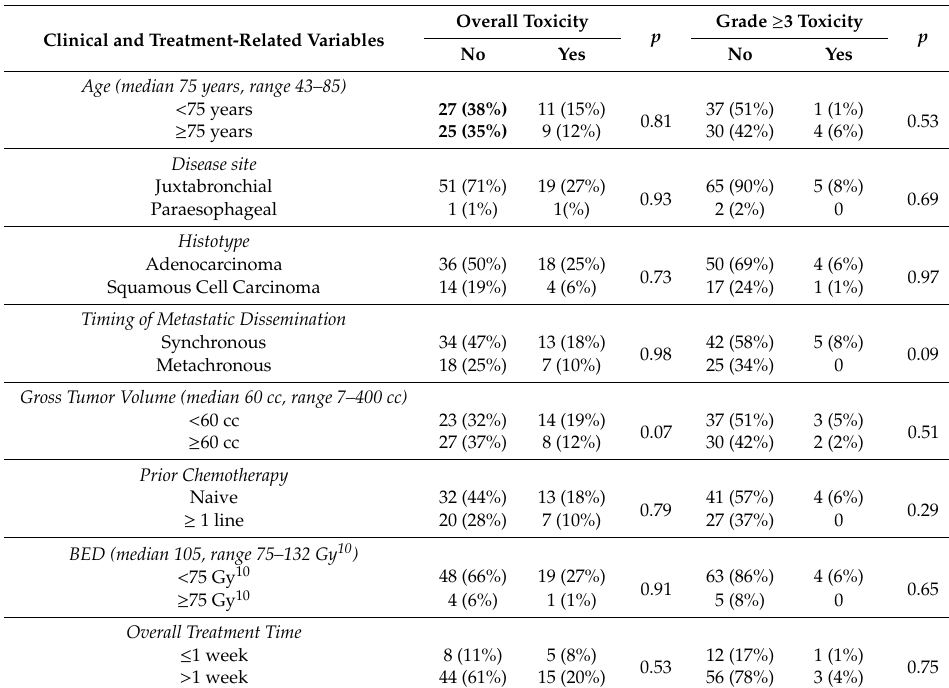
Table 3. Clinical and treatment-related variables and impact on overall and grade ≥ 3 toxicity. NR: not reached; BED: biologically e ff ective dose. Italic: variable